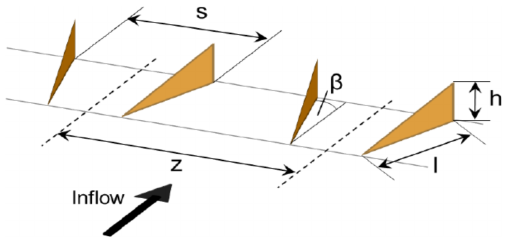
Figure 4. Illustration of the geometrical characteristics of the vor- tex